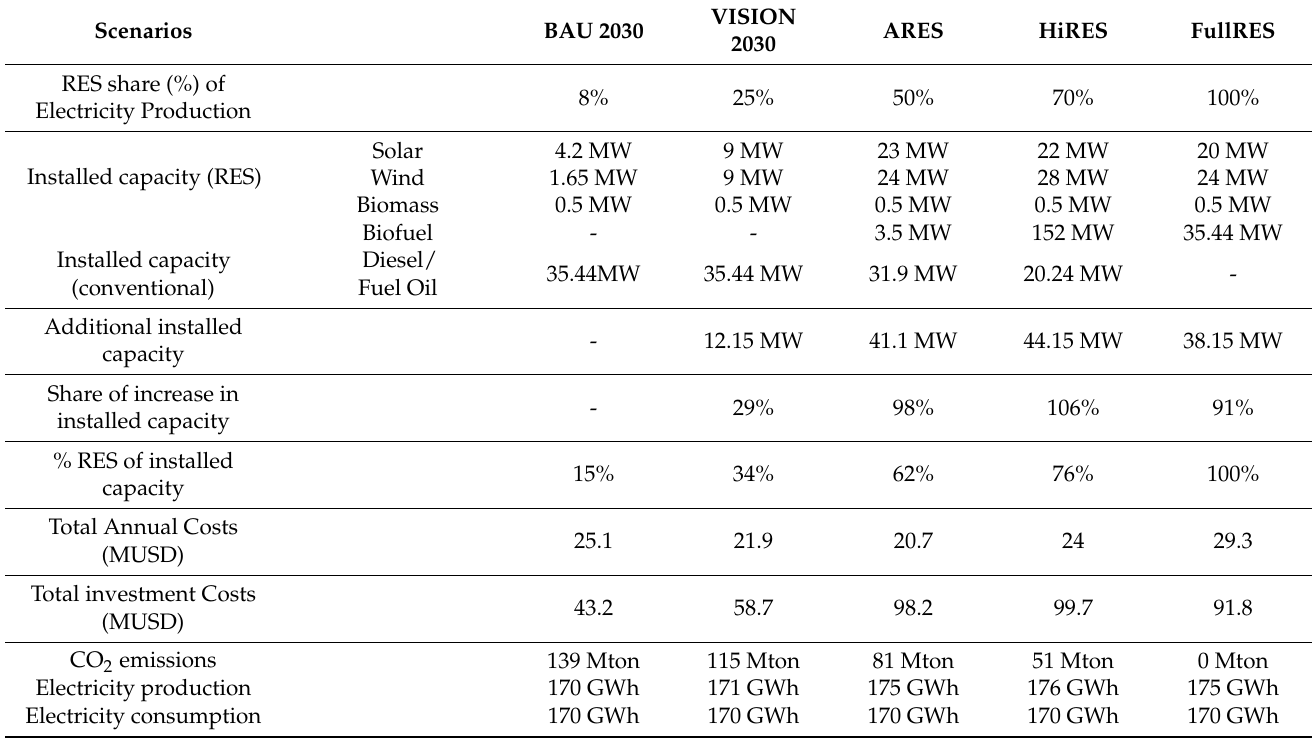
Table 1. Scenario inputs and summary of